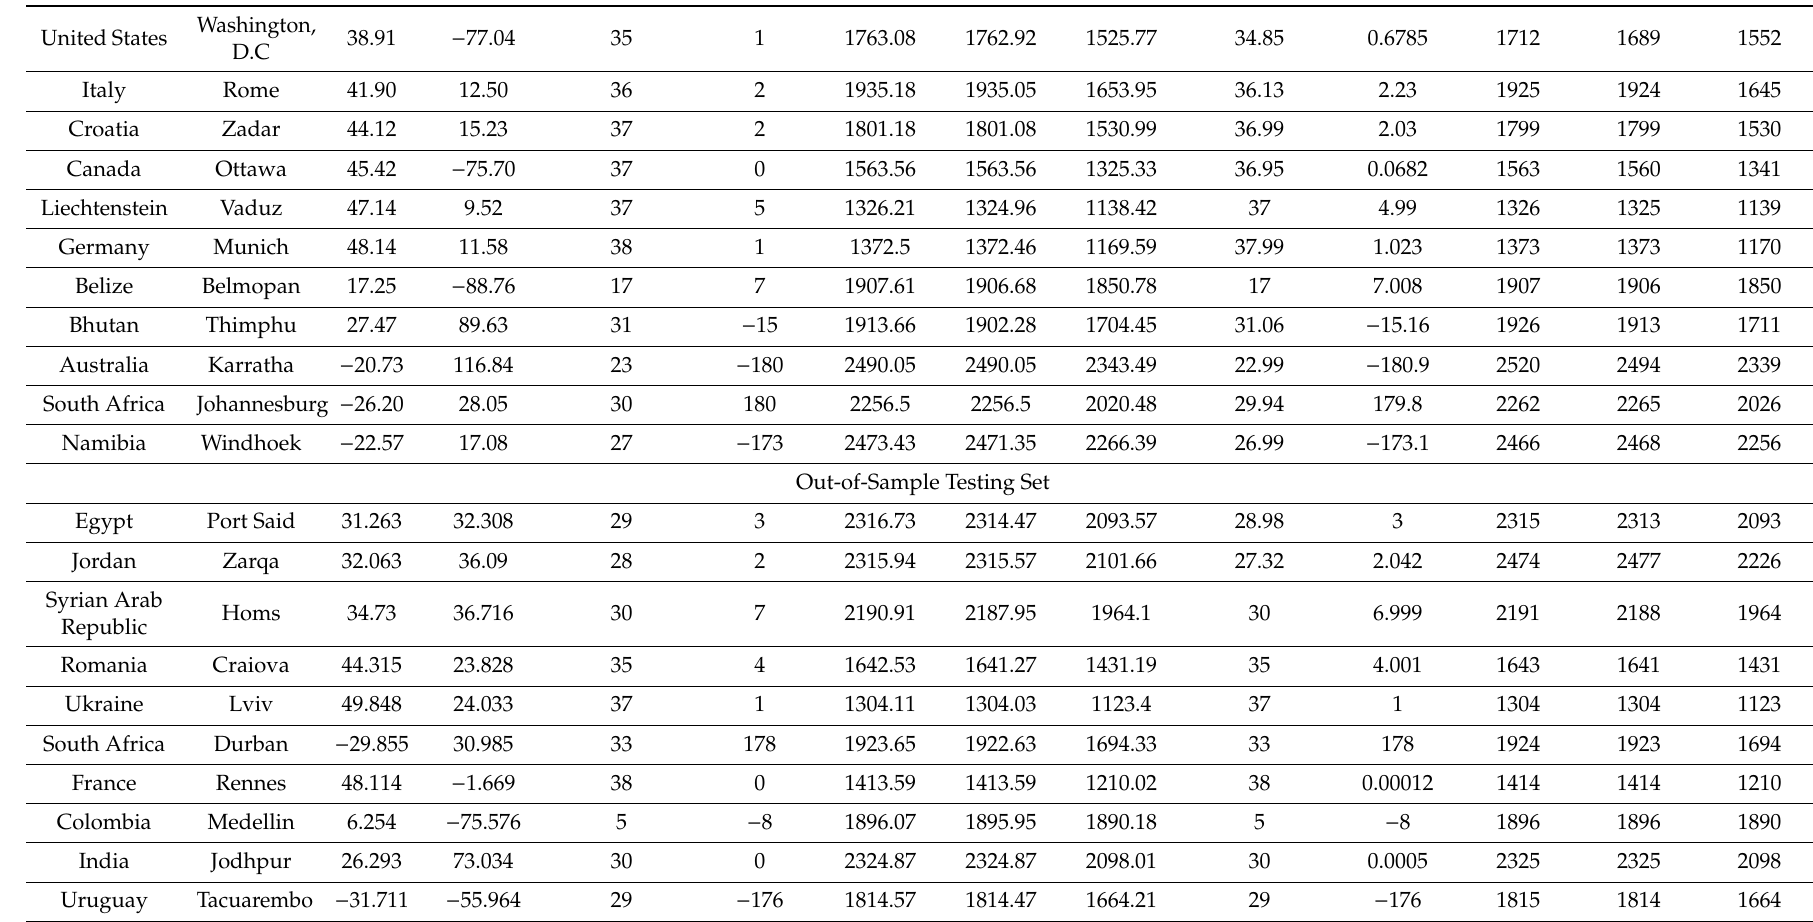
AR1: annual irradiation (kWh / m 2 ) at optimum tilt angle and orientation. AR2: annual irradiation (kWh / m 2 ) at optimum tilt angle (azimuth angle = 0 for Northern Hemisphere and 180 for Southern). AR3: annual irradiation (kWh / m 2 ) at horizontal surface. DR1: daily average irradiation (kWh / m 2 / day) at optimum tilt angle and orientation. DR2: daily average irradiation (kWh / m 2 / day) at optimum tilt angle (azimuth angle = 0 for Northern Hemisphere and 180 for Southern). DR3: daily average irradiation (kWh / m 2 / day) at horizontal